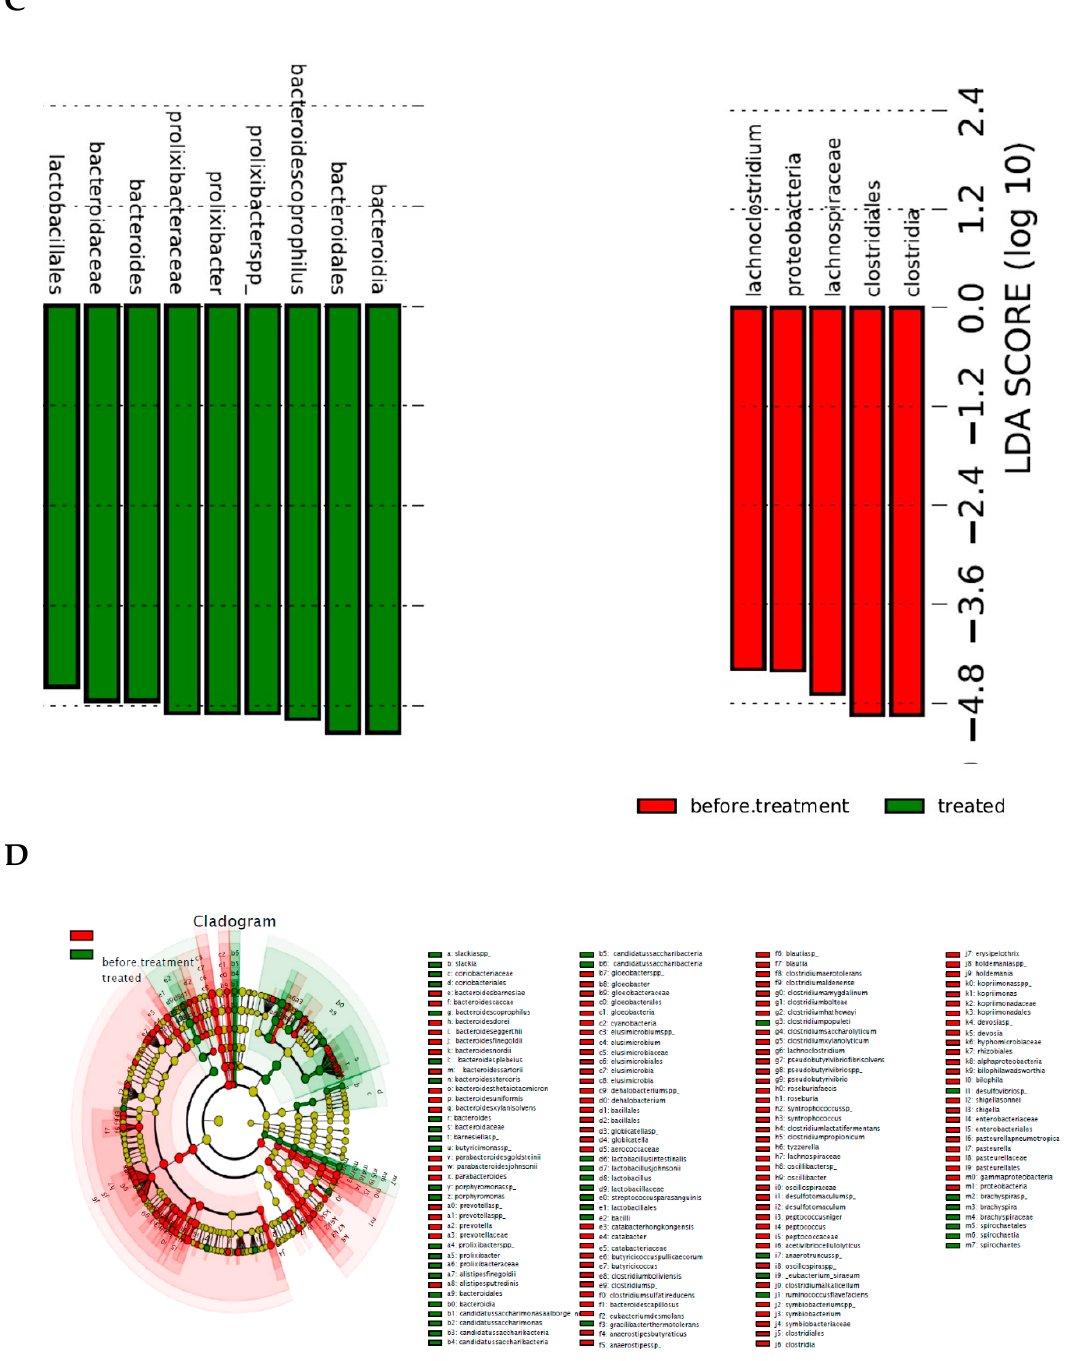
Figure 4. Effect of saffron on the gut microbiome composition. Rats were given saffron in their drinking water (~120 mg/day). Stool samples were collected before and after 4 weeks and stool DNA extracts were used to analyze the gut microbiome structure and changes in the two groups (Control group which drank plain water and case group fed saffron). Ten stool samples from each of the two groups were used to extract DNA samples for bacterial community analysis. A PCR amplification targeting the 16S rRNA gene using universal bacterial primers was performed and the PCR products were sequenced. Treatment with saffron led to major changes at the phylum level. ( A ) Average abundance of different microbiomes before and after saffron treatment in rats. Treatment with saffron led to major changes at the phylum level. Red bars indicate bacterial phyla in untreated while the green bars show the prevalence of different phyla in saffron treated rats. A dramatic reduction of Cyanobacteria and Proteobacteria and a less dramatic decrease in Bacteroidetes and Firmicutes phyla